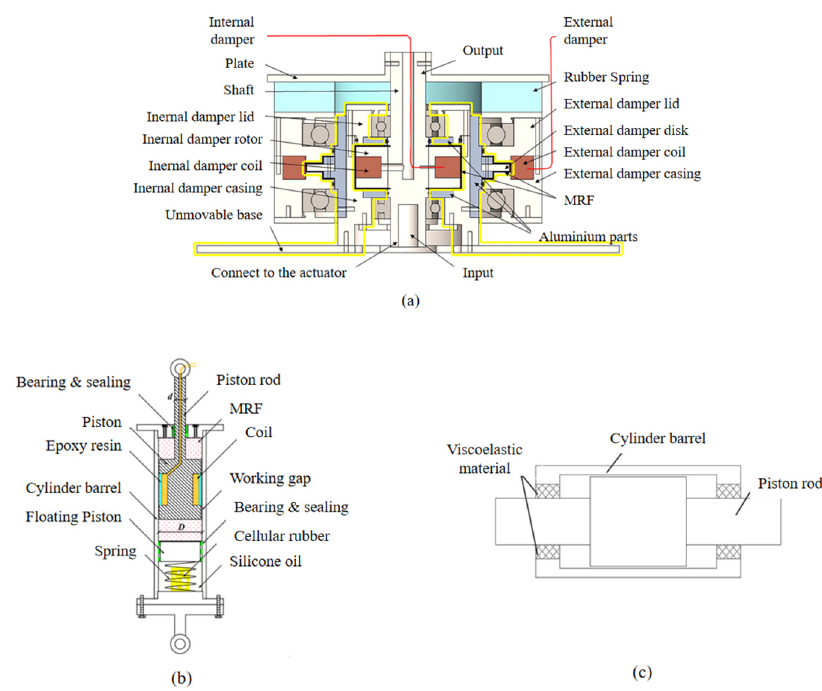
Figure 16. Hybrid MRDs with particular part type: ( a ) New rotating MRD with variable stiffness and variable damping [93]; ( b ) single rod MRD with combined volume compensator [94]; ( c ) leak-proof MRD [97].